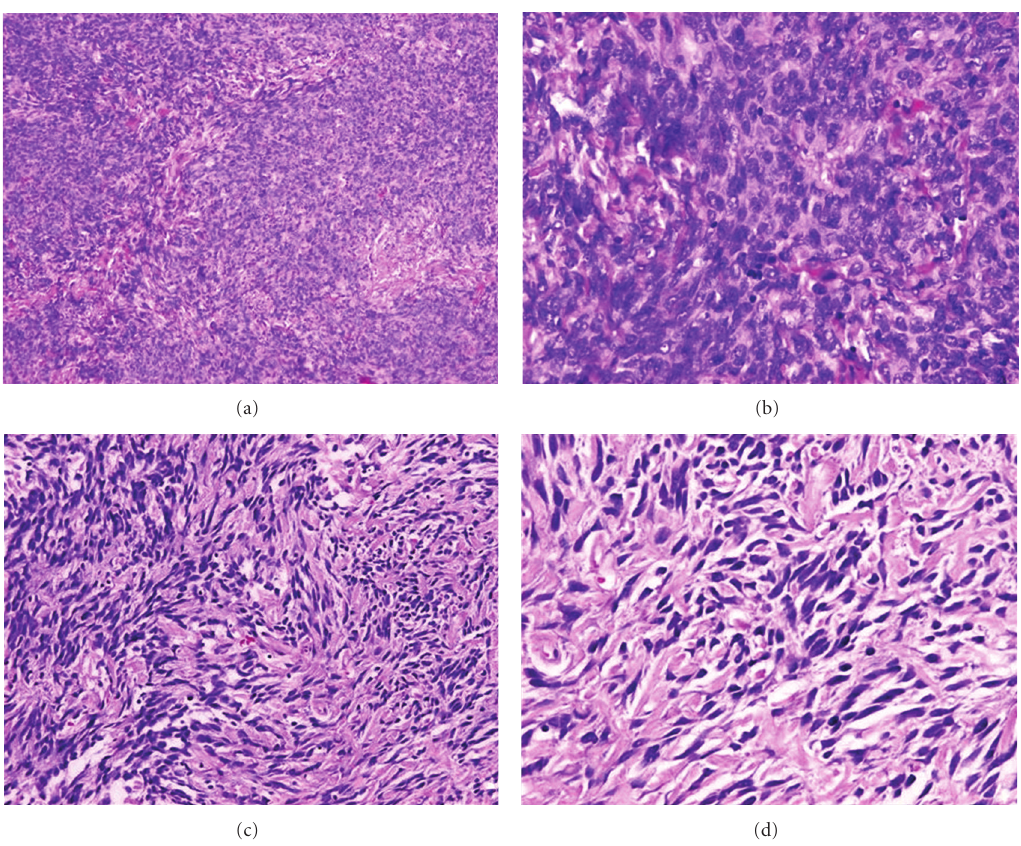
Figure 1: Histological features of low-grade prostatic sarcoma. Di ff use proliferation of epithelioid cells ((a) (10 XHPF) and (b) (40 XHPF)) and spindle cells, with a storiform and infiltrative growth pattern ((c) (20 XHPF) and (d) (40